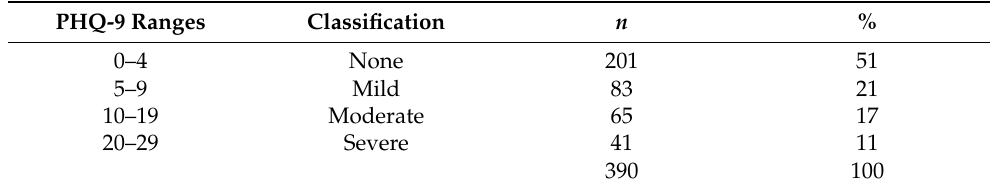
Table 4. Screening results for depression symptoms using PHQ-9.